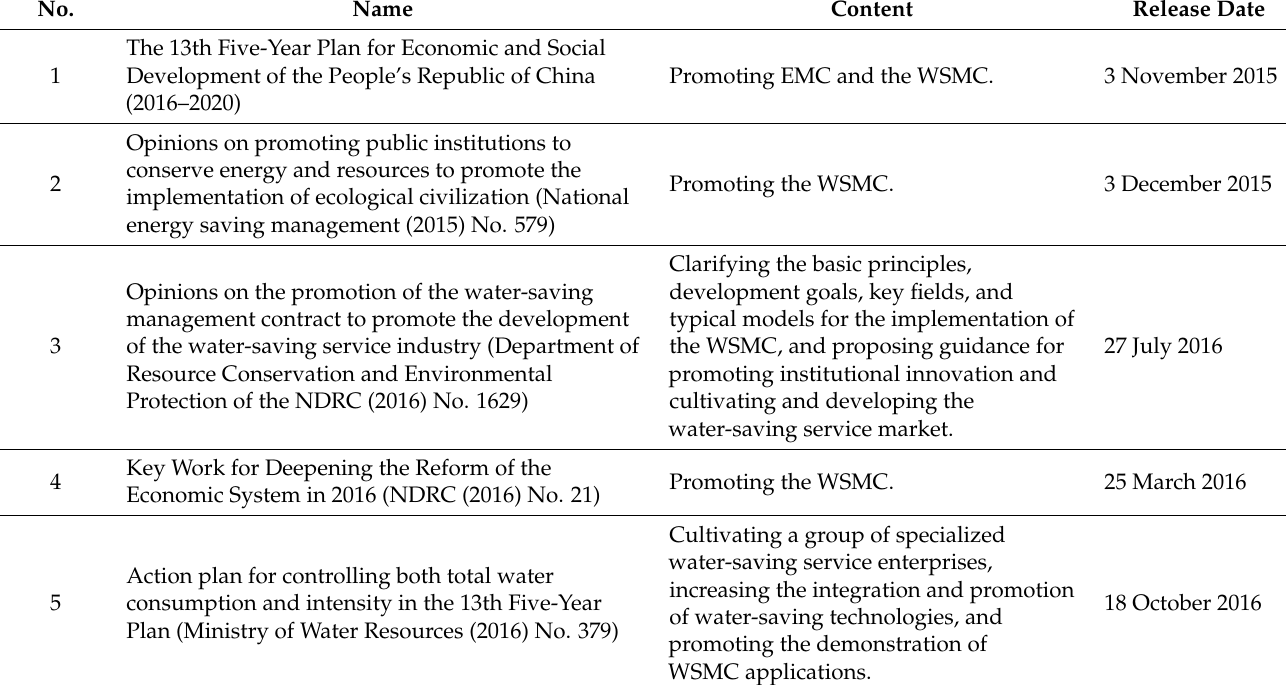
Table A1. Summary of policies that include the WSMC in